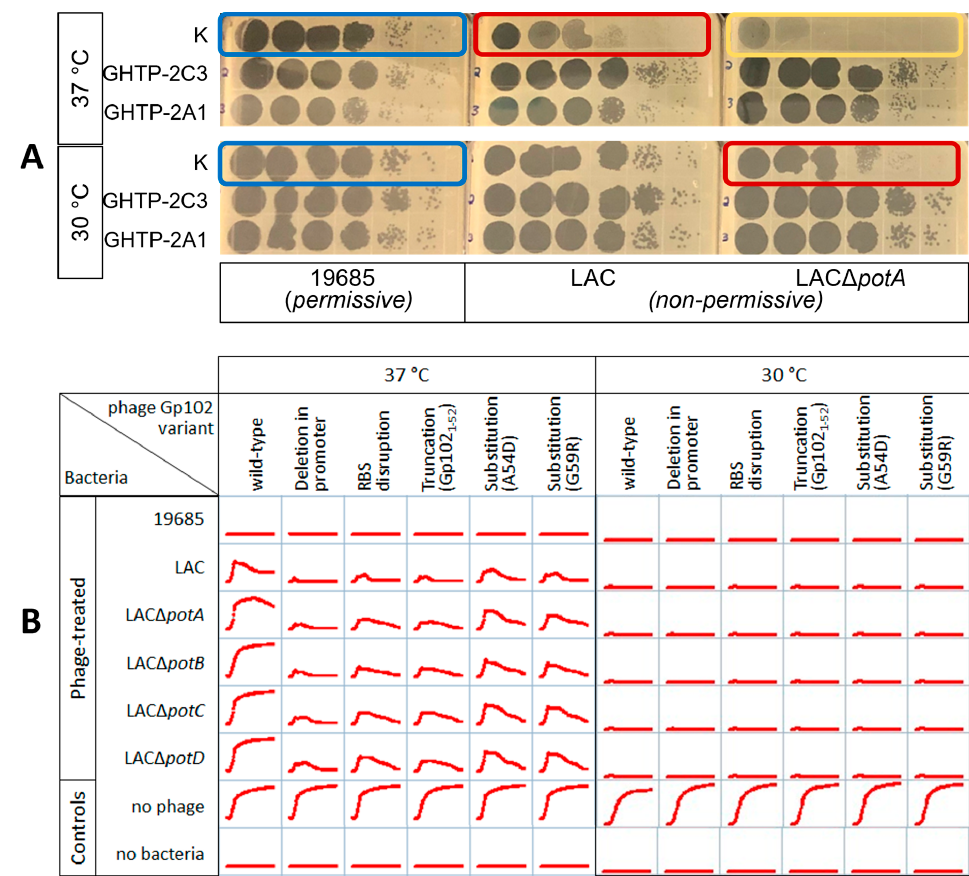
Figure 1. Gp102 loss-of-function mutations in phage K result in larger, clearer plaques and better growth suppression under non-permissive culture conditions (growth at 37 °C on LAC). ( A ) 10-fold dilution series of wild-type (WT) K and two gp102 loss-of-function mutants. On the permissive host, growth of wild-type K is not temperature-sensitive (blue boxes). On the non-permissive hosts, the effects of temperature and deletion of polyamine transporter components (red boxes) are additive, further reducing plaque formation (gold box) unless gp102 function is impaired. ( B ) 24 h bacterial growth curves in 96-well plates show the differential abilities of wild-type phage K and various types of gp102 loss-of-function mutants to suppress growth of permissive and non-permissive S. aureus strains. Each well initially contained approximately 3 × 10 6 CFU and 2 × 10 5 PFU.